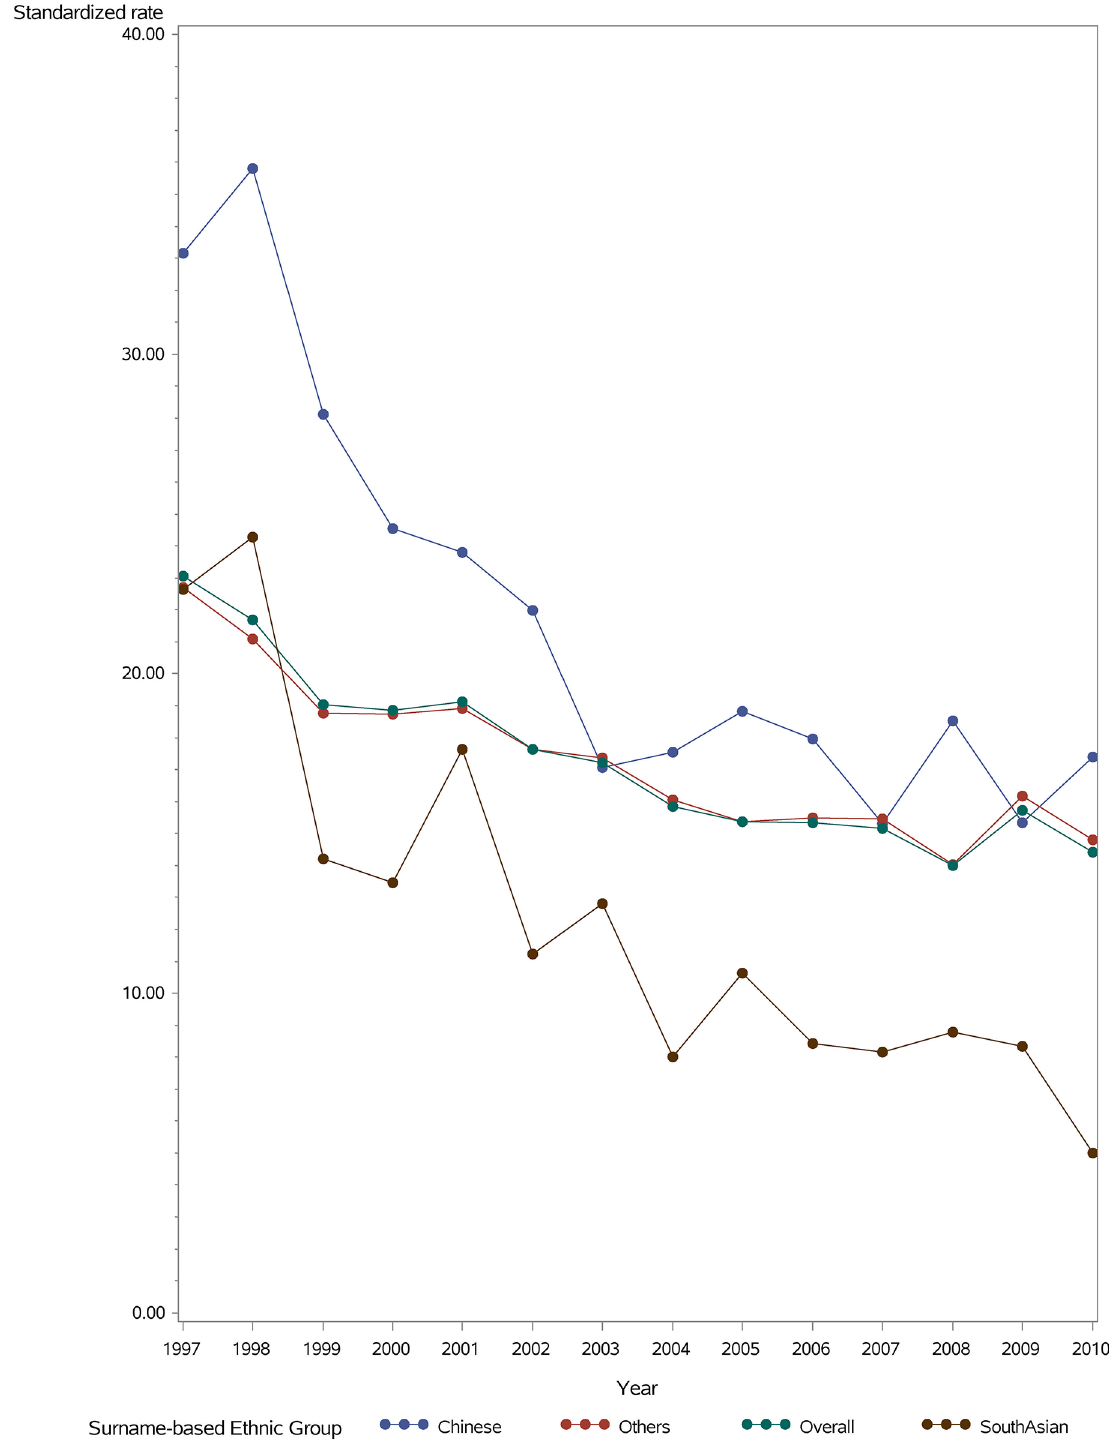
Fig 3. Age and sex standardized incidence of intracerebral hemorrhage per 100,000persons by ethnic group, 1998to 2010.